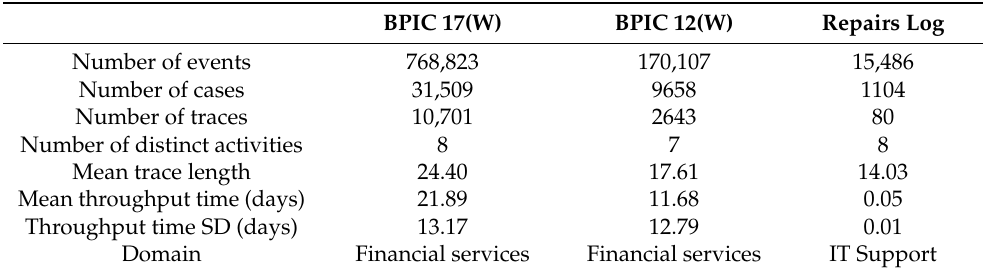
Table 2. Event Log